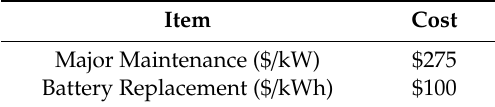
Table 4. Major maintenance and battery replacement costs for lithium-ion systems.